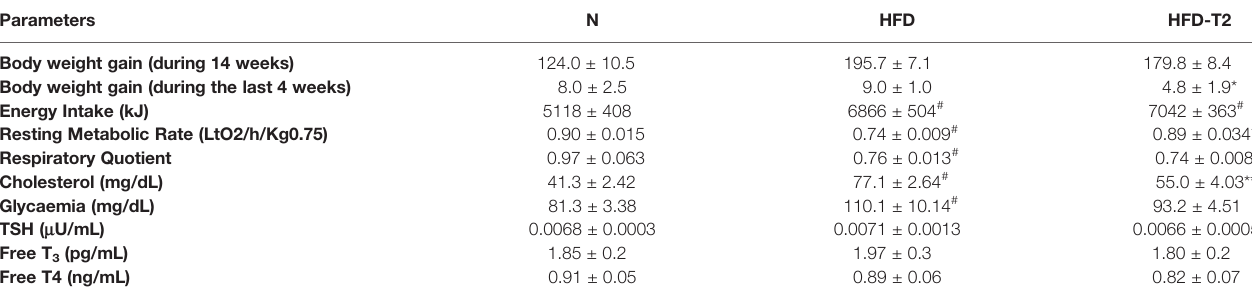
TABLE 1 | Body weight gain, energy intake, resting metabolic rate, respiratory quotient, serum cholesterol levels, glycaemia and serum TSH, FT3, FT4 in N, HFD and HFD-T2 rats. Parameters N Body weight gain (during 14 weeks)